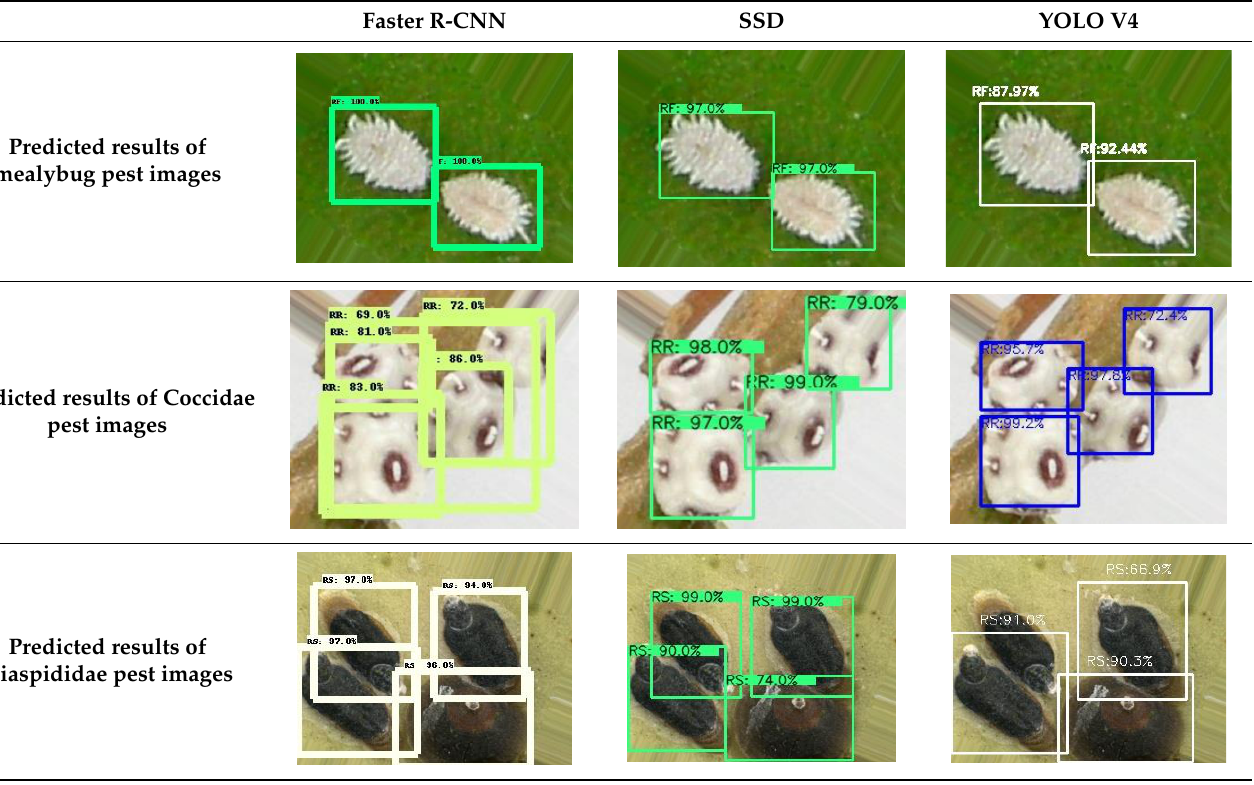
Table 2. Performance comparison of three-scale recognition between Faster R-CNN and SSD models.